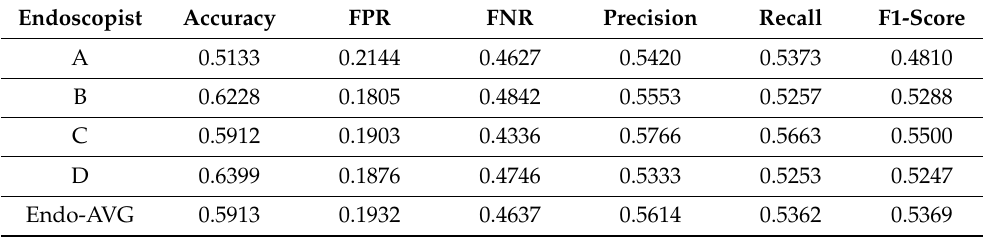
Table 2. Classification results of the four